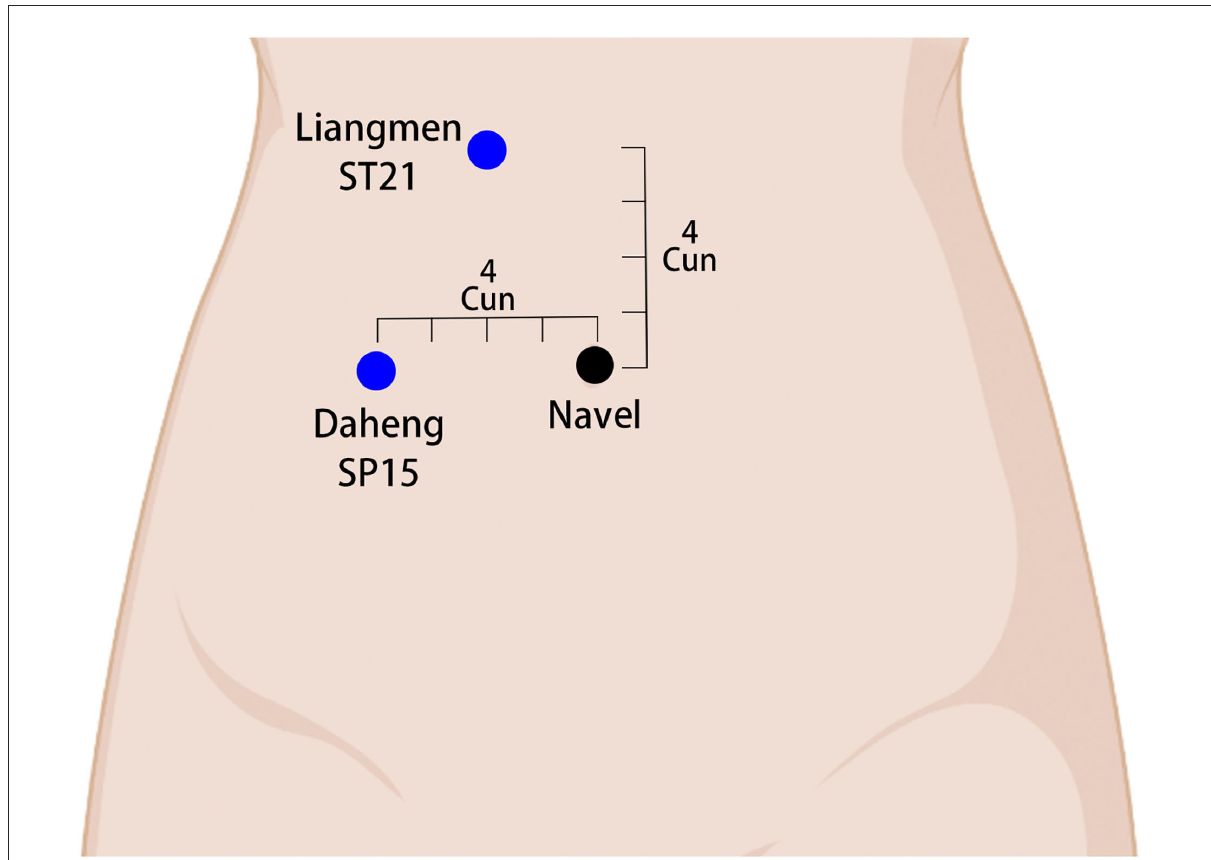
FIGURE2 Localization of abdomen acupoints and electrode connection. ST21 (Liangmen) in the upper abdomen, 4 cun above the navel and 2 cun from the anterior midline. SP15 (Daheng) in the ventral part, 4 cun from the navel. A set of electrodes is attached at the blue dot (transcutaneous electrical acupoint